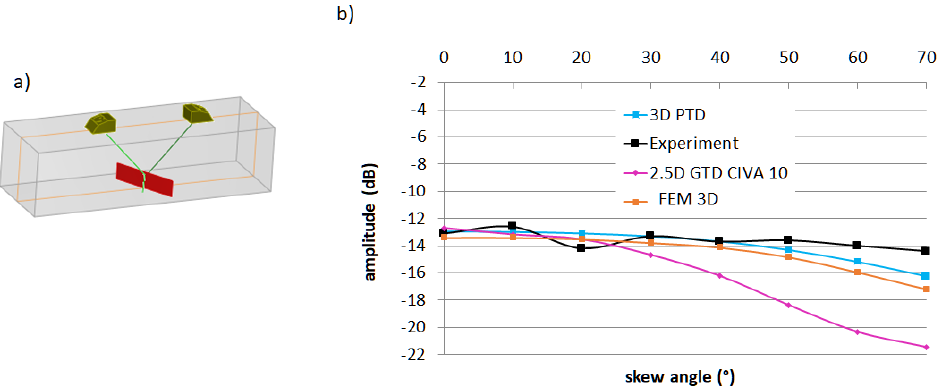
Figure 12. ( a ) TOFD configuration on a skewed backwall breaking crack; ( b ) top edge diffraction echoes amplitudes versus skew angle for measure, 2.5D GTD and 3D PTD and FEM simulations.